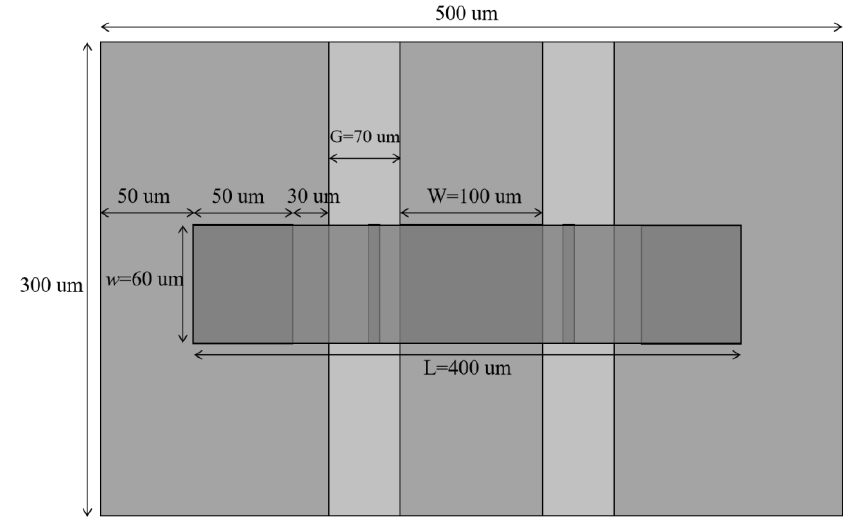
Figure 2. MEMS capacitive parallel switch top view.